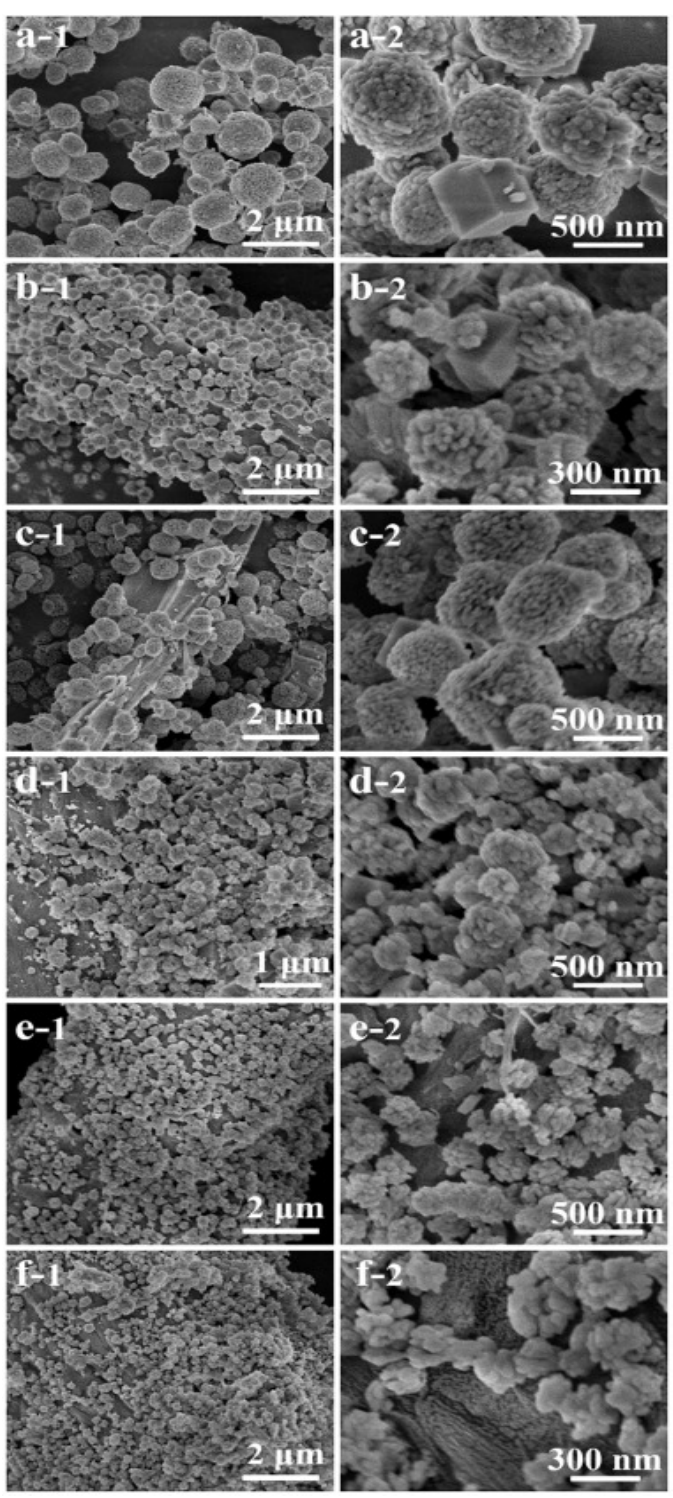
Figure 4. SEM images of the products prepared with different cellulose concentrations: ( a ) the control sample obtained without cellulose; ( b ) 0.51 mg mL − 1 ; ( c ) 1.01 mg mL − 1; ( d ) 2.03 mg mL − 1 ; ( e ) 4.05 mg mL − 1 ; ( f ) 8.10 mg mL − 1 . This Figure is adapted with permission from [17].